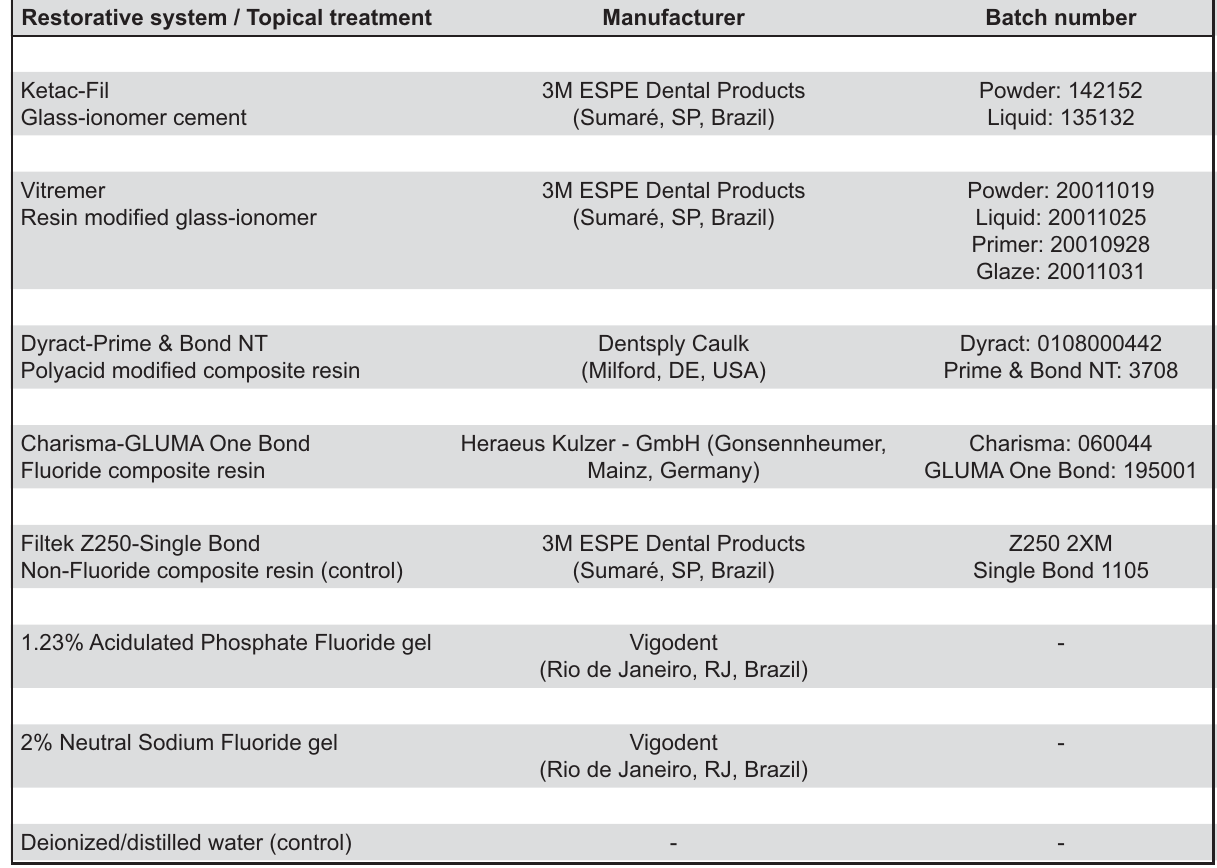
Figure 1- The restorative materials and topical treatments applied to the specimens